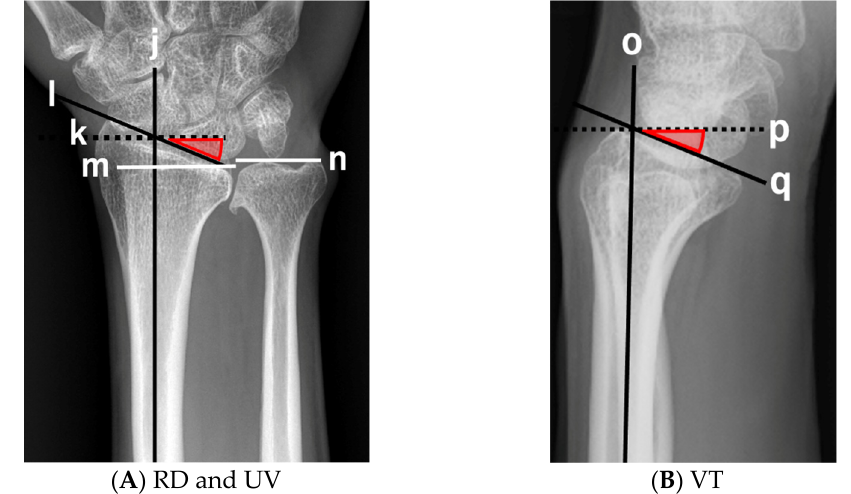
Figure 1. Index measurement of the elbow joint. A: tip of the coronoid process, AB: linear distance between point A and the posterior olecranon line, CD: minimal proximal ulna trochlear height, E: tip of the olecranon process, F: midpoint of the segment from AE, G: deepest point of the trochlear notch (determined by the intersection of a line perpendicular to AE and passing through point G and the trochlear notch), h: posterior olecranon cortex line, i: posterior ulna cortex line. ( A ) Proximal Ulnar Bow (PUB) is determined by lines h and i. ( B ) Radiographic Opening Angle (ROA) is deter- mined by lines AG and GE. ACI, Anterior Coverage Index; TDI, Trochlear Depth Index.